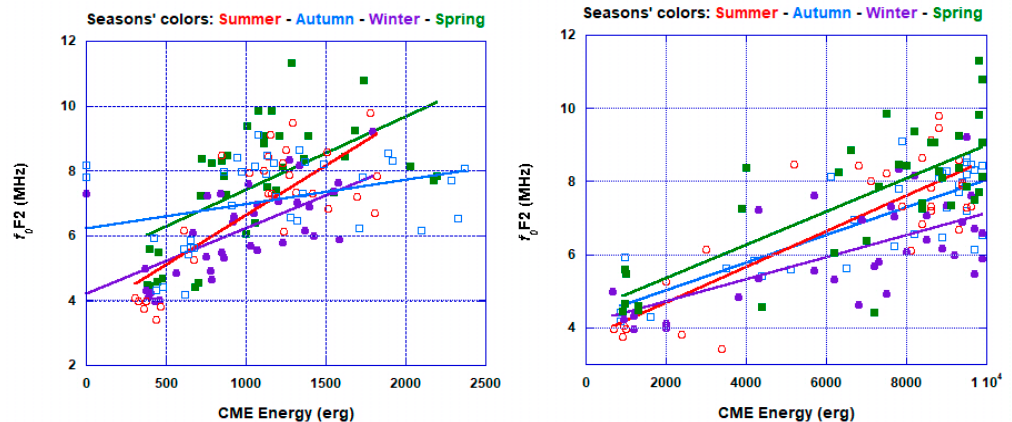
Figure 6. The seasonal variation of the monthly average f 0 F2 with the monthly average CME energy ( left panel) and the monthly maximum CME energy ( right panel). The season points and its fitting line are colorized as in the figure’s caption of each season word’s color.